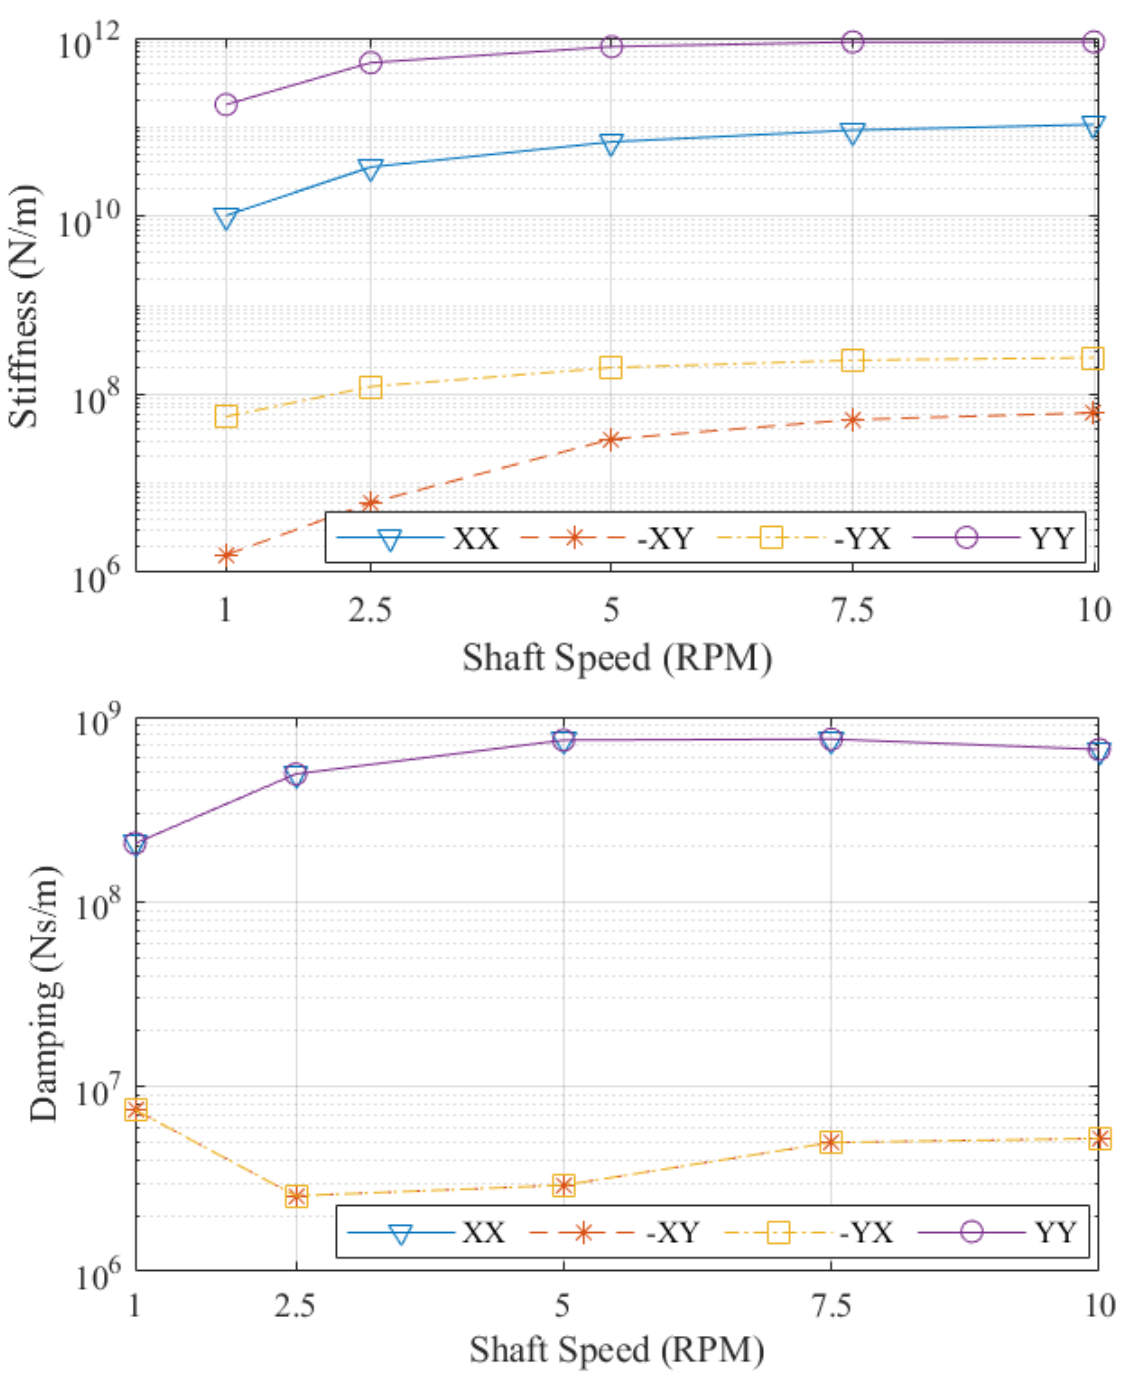
Figure 5. Speed-dependent properties of the fluid film bearings.